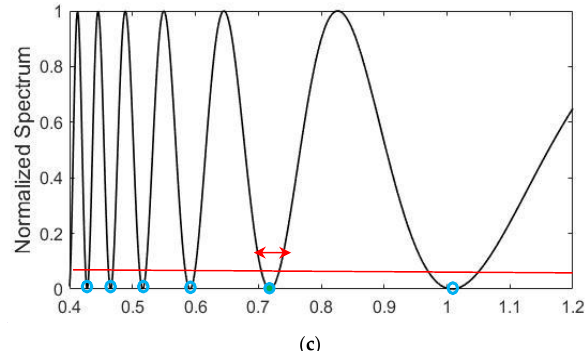
Figure 8. The output spectrum S out ( λ ) for three P2 polarization angles. ( a ) θ 2 = 0 ◦ . ( b ) θ 2 = 45 ◦ . ( c ) θ 2 = 90 ◦ . The red line and arrow are used in the